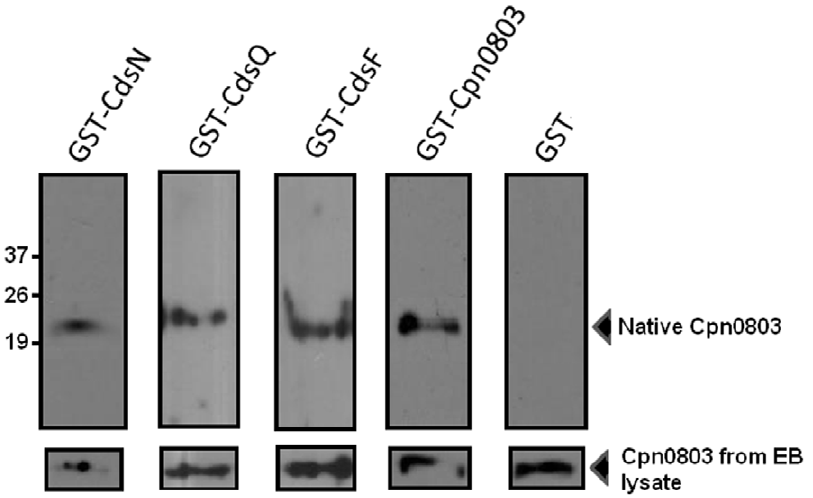
Figure 2. Cpn0803 interacts with type III secretion components invivo . C. pneumoniae EB lysates were incubated with recombinant GST- CdsN, -CdsF, -CdsQ or -Cpn0803. Glutathione agarose beads were incubated with the lysates overnight, collected, and washed with 500 mM NaCl. The protein on the beads was analyzed by SDS PAGE and Western blot with anti-Cpn0803 antibody. Native Cpn0803 co-purified with GST-CdsN, -CdsF, and -CdsQ. As a positive control, Cpn0803 also co-purified with GST-Cpn0803, but not with GST alone.